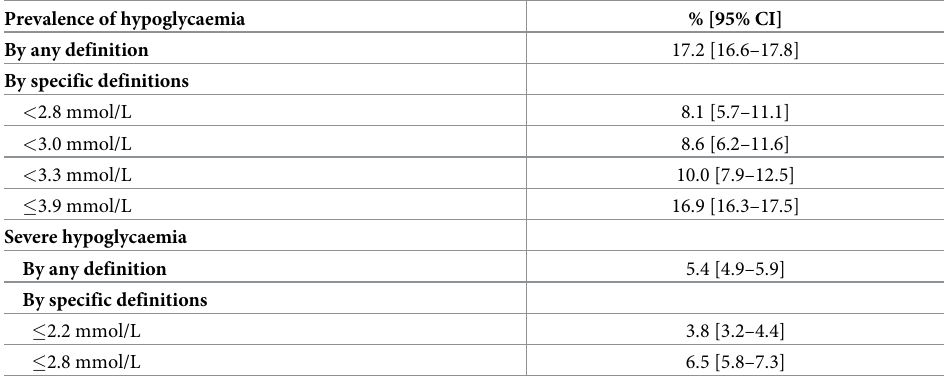
Table 3. Prevalence of hypoglycaemia and severe hypoglycaemia (by any definition and specified definitions). Prevalence of